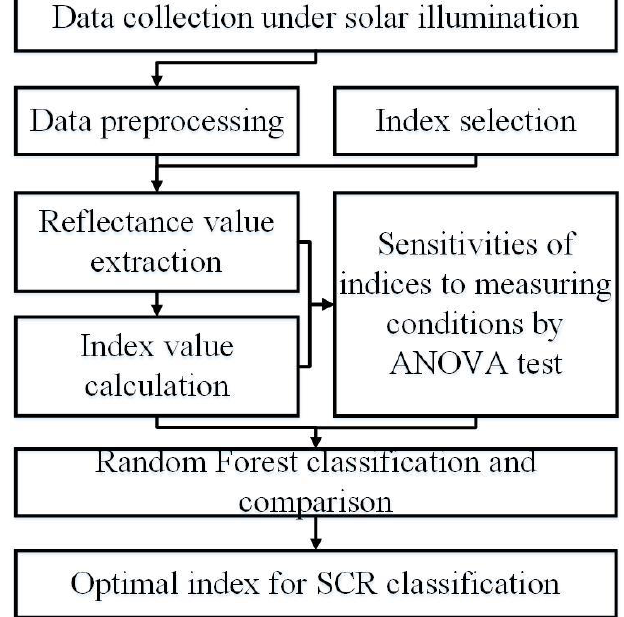
Figure 2. Overall workflow of this study.